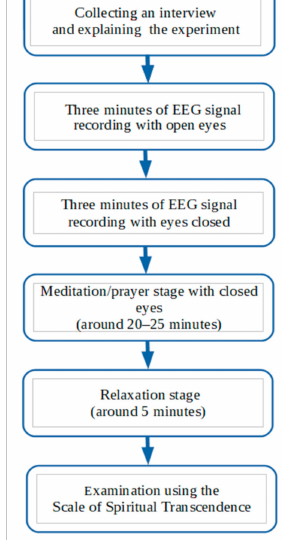
Figure 1. Stages of the